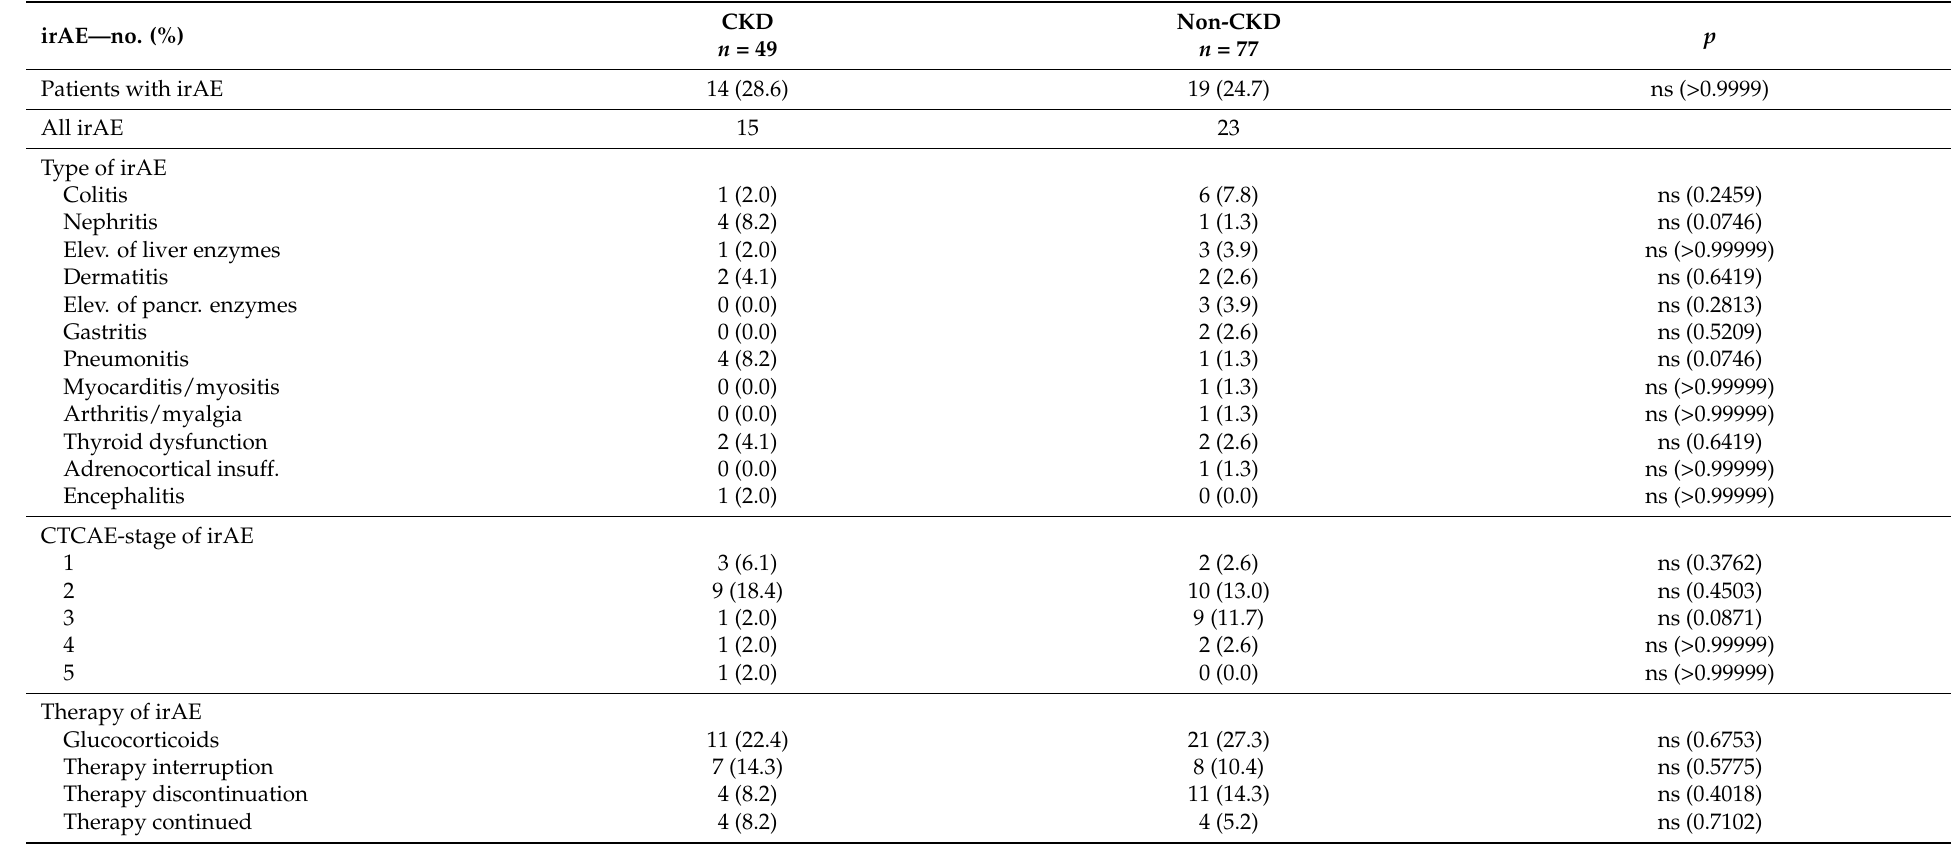
Table 5. Immune-related adverse events during checkpoint inhibitor therapy. CTCAE = common toxicity criteria for adverse events; elev. = elevation; irAE = immune-related adverse event; pancr. = pancreatic; insuff. = insufficiency. CKD = chronic kidney disease; ns = not